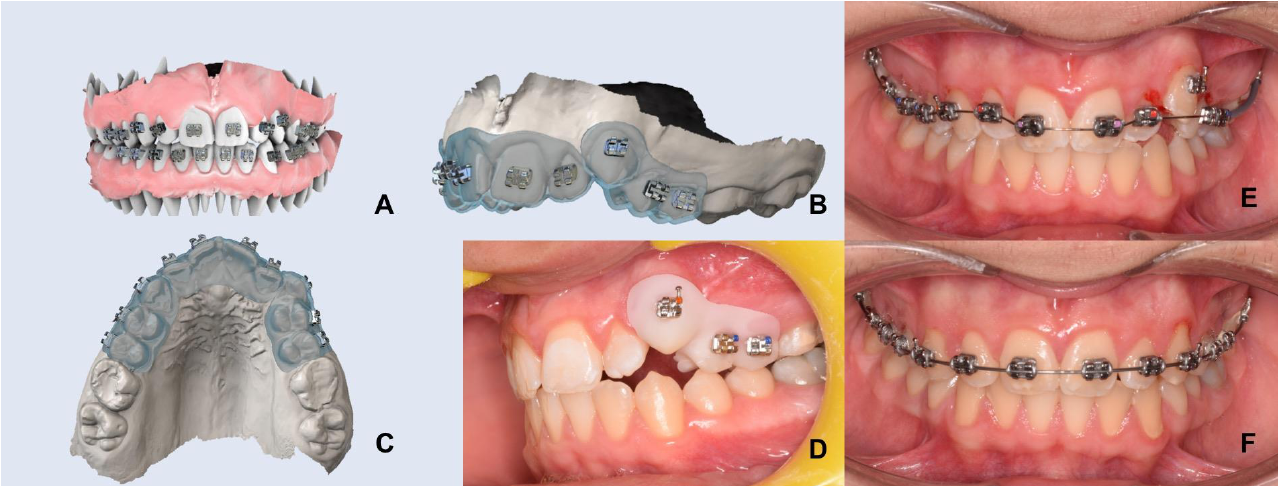
Figure 15. Example of digitally planned brackets position according to the digital setup and 3D printing of indirect bonding guide using Maestro software (AGE Solutions SRL, Pisa, Italy). ( A ), Digitally planned brackets position; ( B ), digitally designed bonding tray (lateral view); ( C ), digitally designed bonding tray (occlusal view); ( D ), indirect bonding procedure with 3D printed bonding tray; ( E ), brackets placed according to the digital orthodontic setup; ( F ), upper arch aligned.